Question: What caption would you write for this figure?
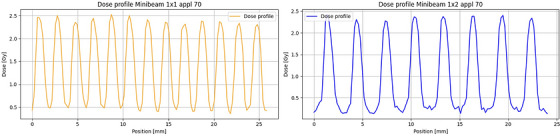
Answer: Transversal dose profile measured with the EBT‐XD RCF placed perpendicular to the beam direction at the entrance (depth = 0 mm) with 9 MeV electron beams at the CPFR using the planar1_2_5 (left) and planar1_3_5 (right) minibeam collimators.